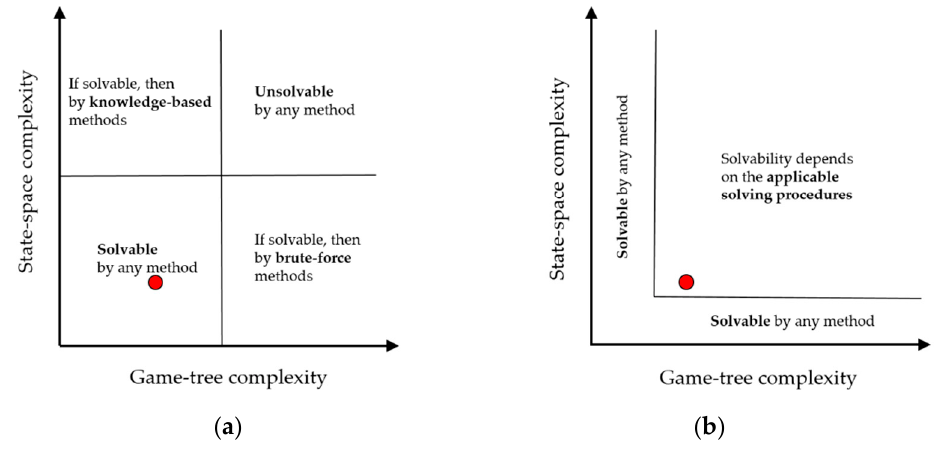
Figure 2. The classical ( a ) and an alternative view ( b ) on the game space according to [38]. The red dot indicates an approximate position of Kalah {10 13 ,10 18 } [54].